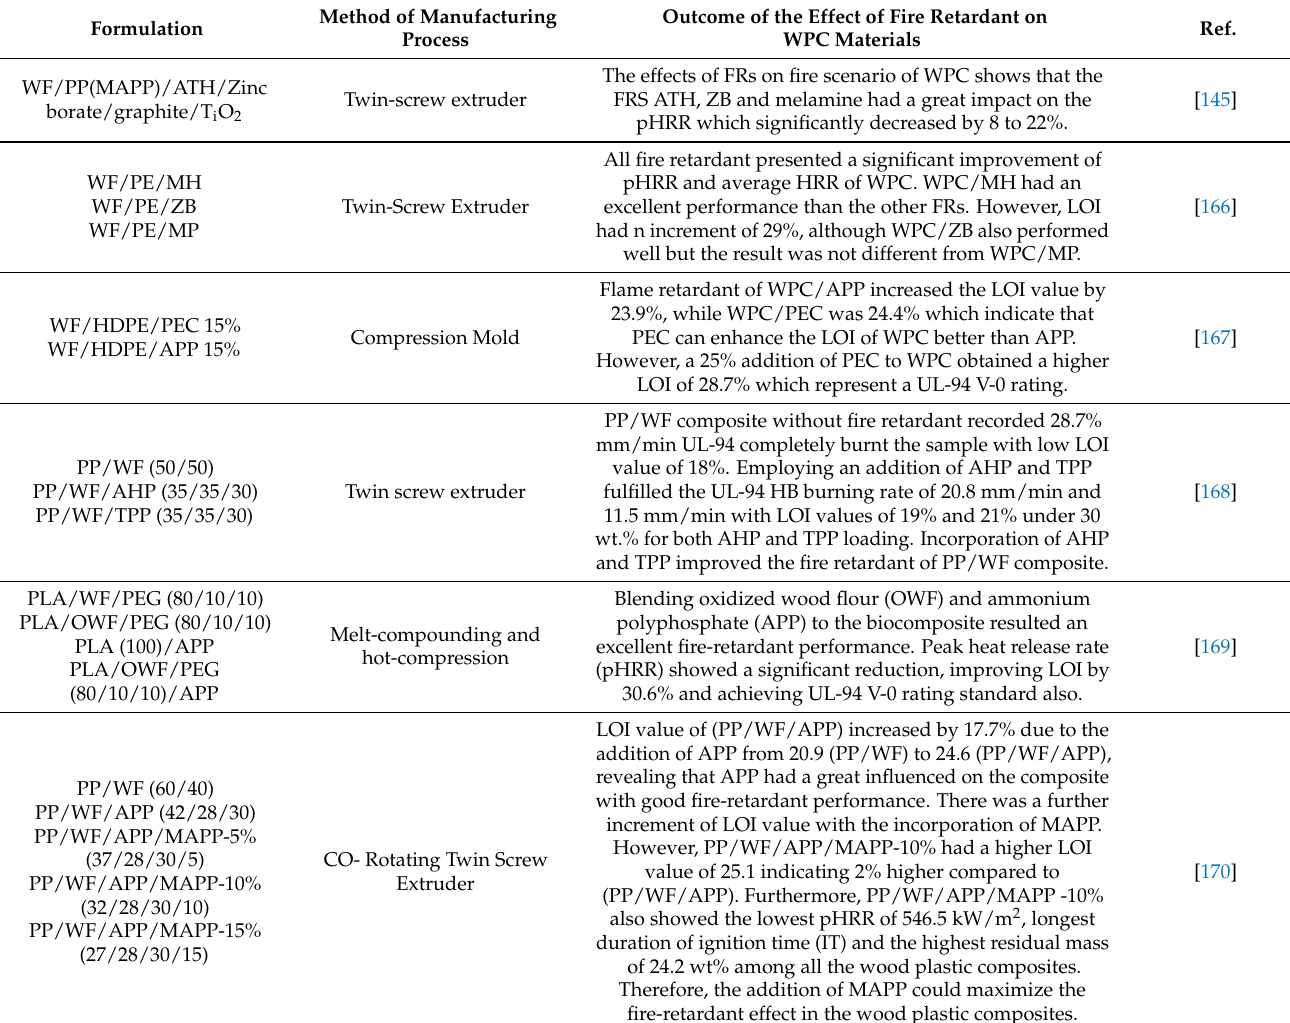
Table 3. WPC with various manufacturing processes and their effective flame retardants [145,166–170]. Method of Manufacturing Outcome of the Effect of Fire Retardant on Formulation Process WPC Materials